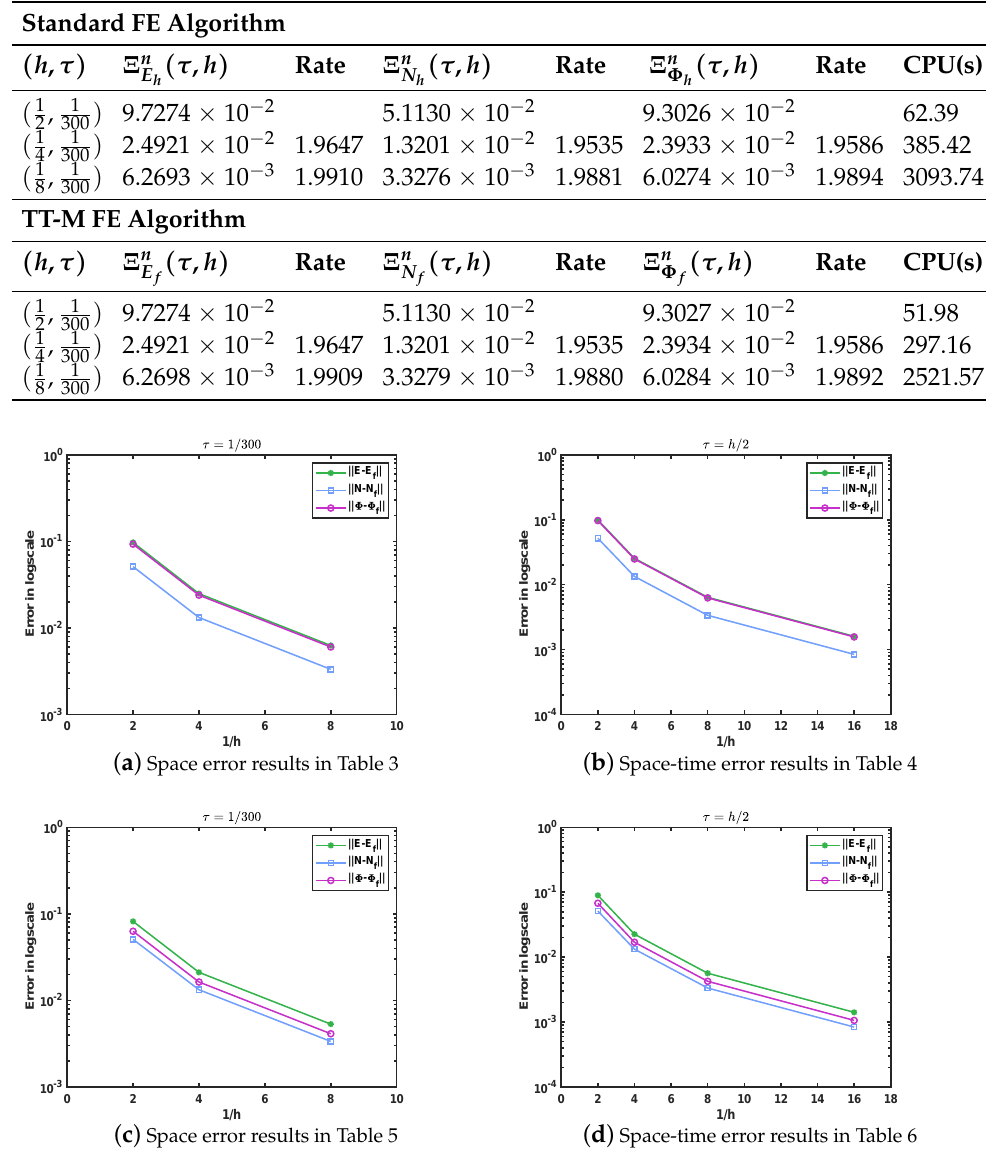
Table 3. Space convergence results for Example 2 in Case 1 with τ C = 4 τ .